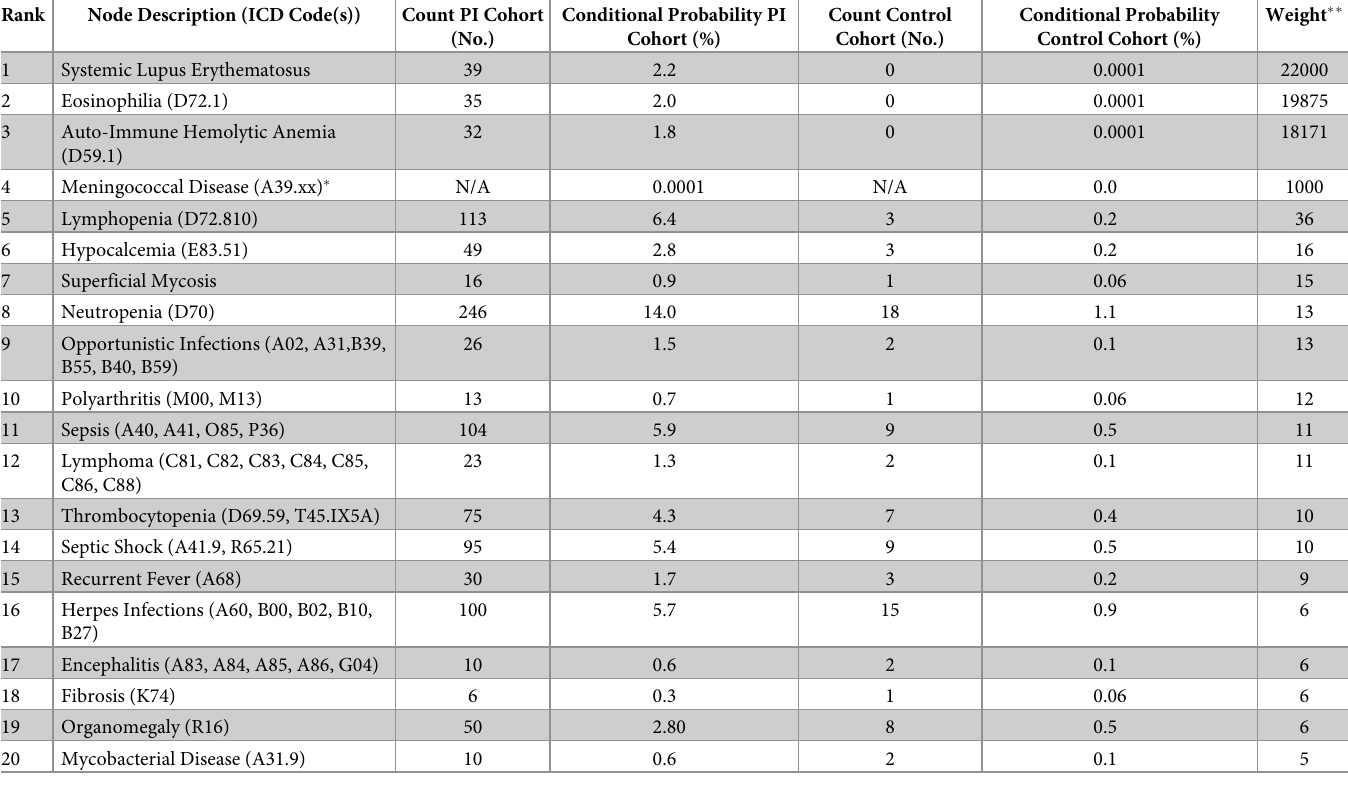
Table 2. Top 20 network features ranked by